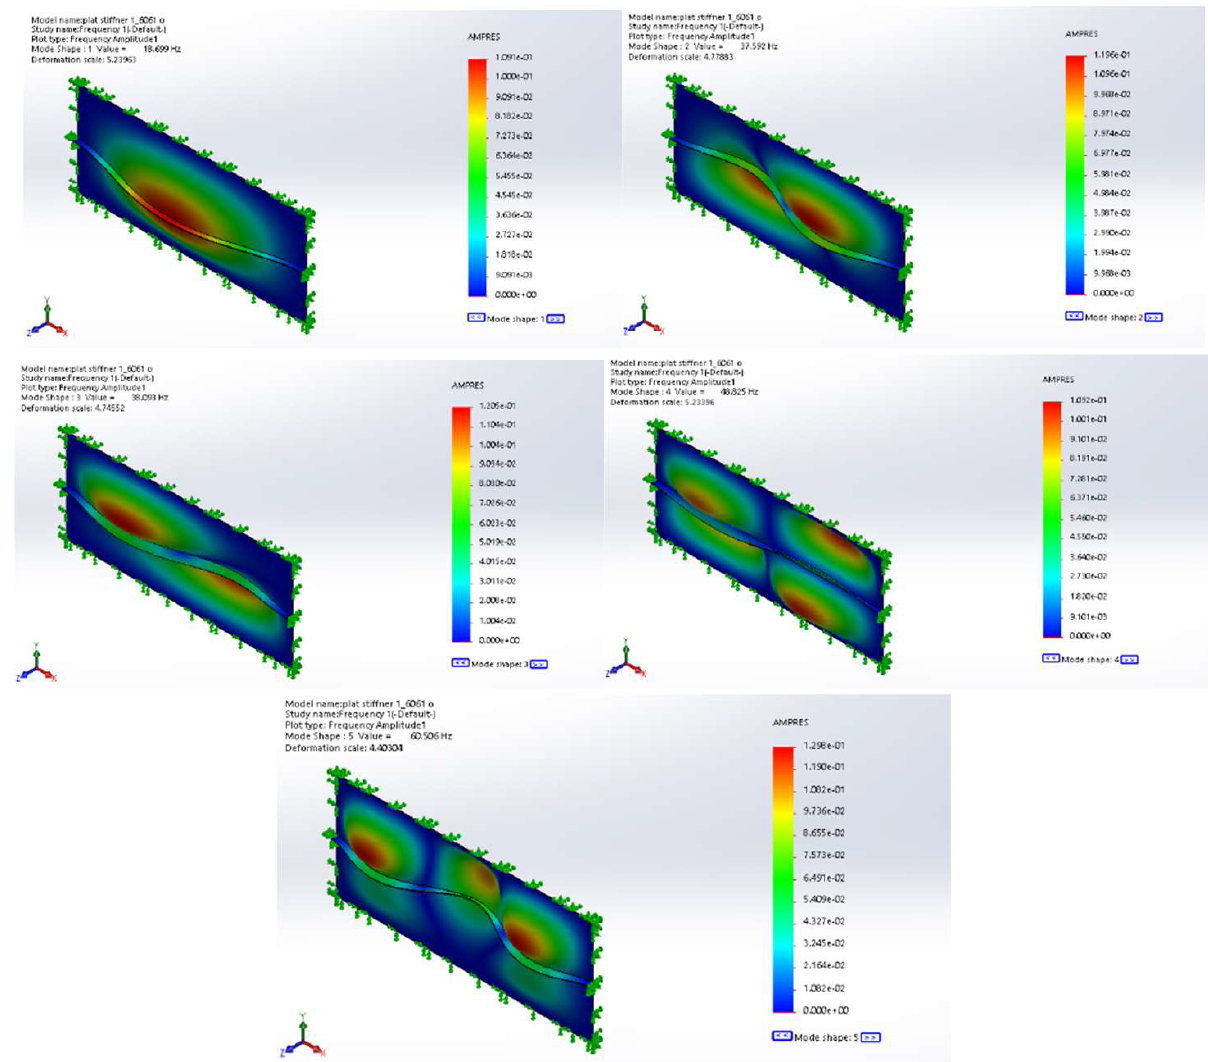
Figure 31: Mode shapes 1–5 of the flat wall a single